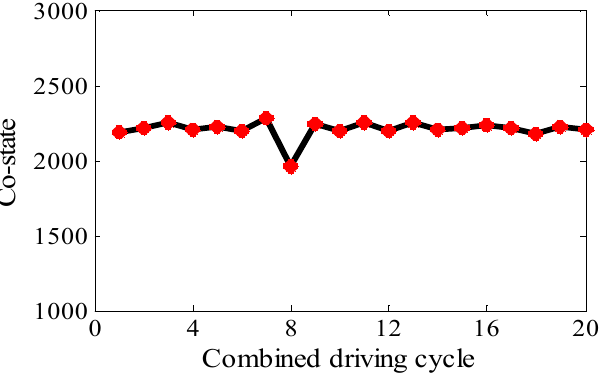
Figure 11. The co-state with different combined driving cycles.